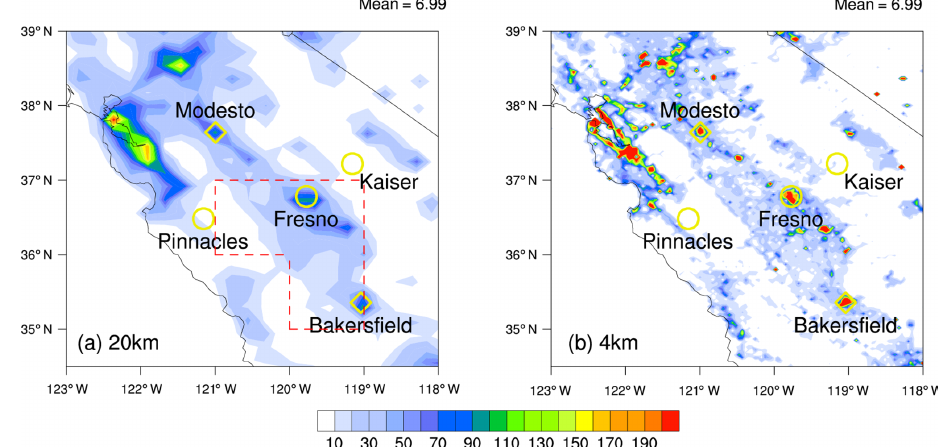
Figure 1. Daily mean anthropogenic PM 2 . 5 emission rate (µgm − 2 h − 1 ) in (a) 20km and (b) 4km simulations. Domain-averaged emission rate is shown at the top right of each panel. Red dashed lines in (a) represent the region used for the domain averages in the discussions. Yellow circle: IMPROVE site; yellow diamond: EPA CSN site. Three urban sites: Fresno, Bakersfield and Modesto; two rural sites: Pinnacles and